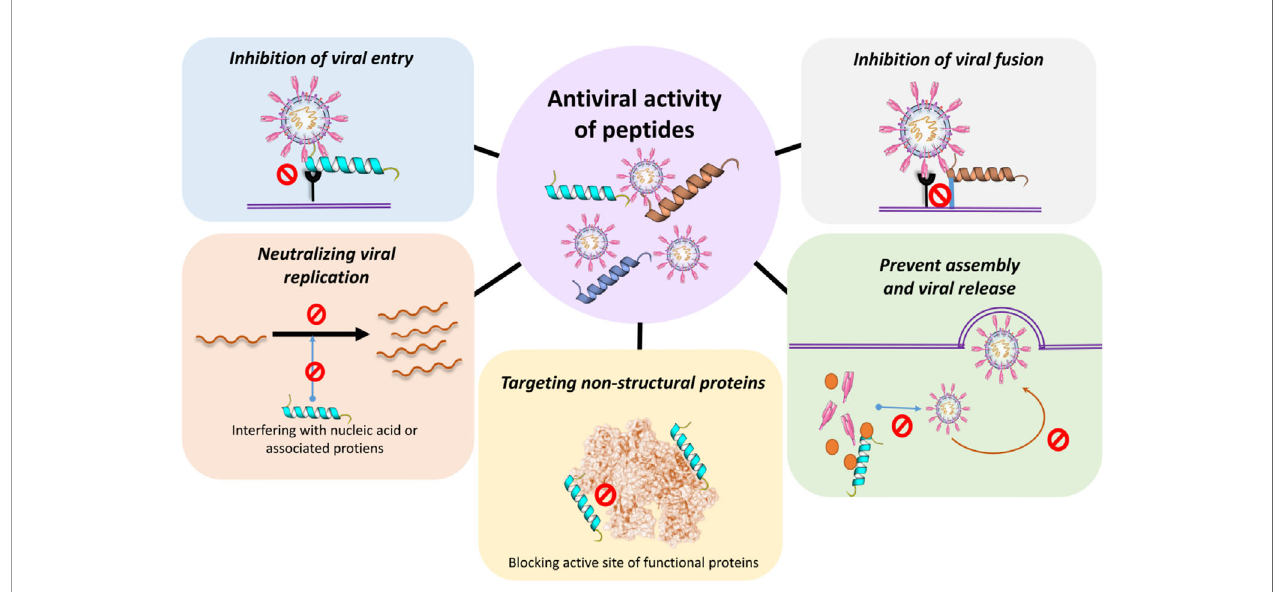
FIGURE 6 | Antiviral activity of peptides. Peptides can directly prevent or inhibit the viral entry, viral fusion and or the assembly and viral release. Peptides can also neutralize viral replication by interacting with relevant proteins inside the cell. For example, blocking the active sites of functional non-structural viral proteins and/or interfering with the generation of nucleic acids directly or via associated